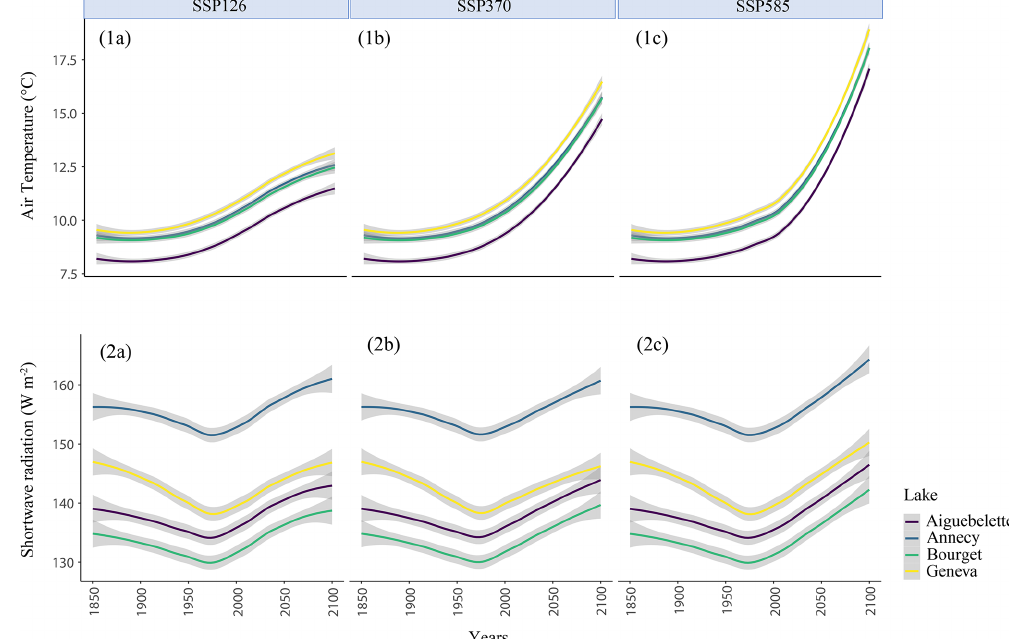
Figure 4. Selected meteorological forcing variables over the studied period of 1850–2100. Projected evolution of air temperature (1) and shortwave radiation (2) from IPSL-CM6A-LR (ISIMIP3b) under SSP126 (a) , SSP370 (b) , and SSP585 (c) for the four lakes (Geneva, Annecy, Bourget, Aiguebelette) (loess statistical method used).